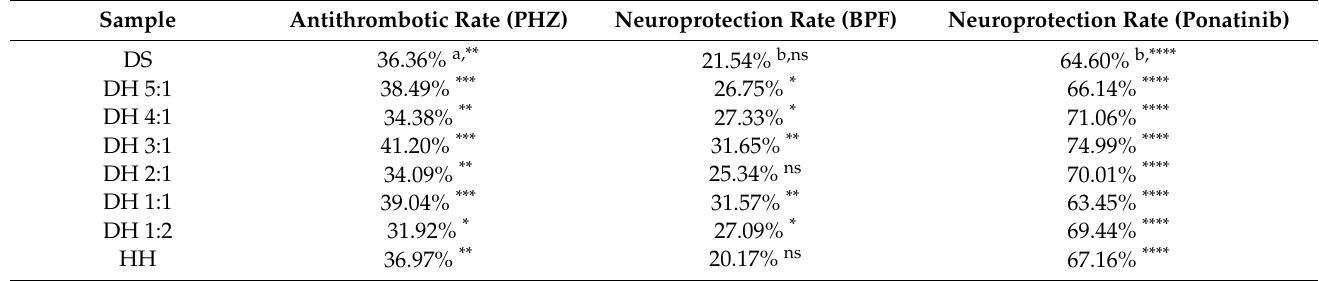
Table 2. Antithrombotic and neuroprotective efficacy of the DH herbal